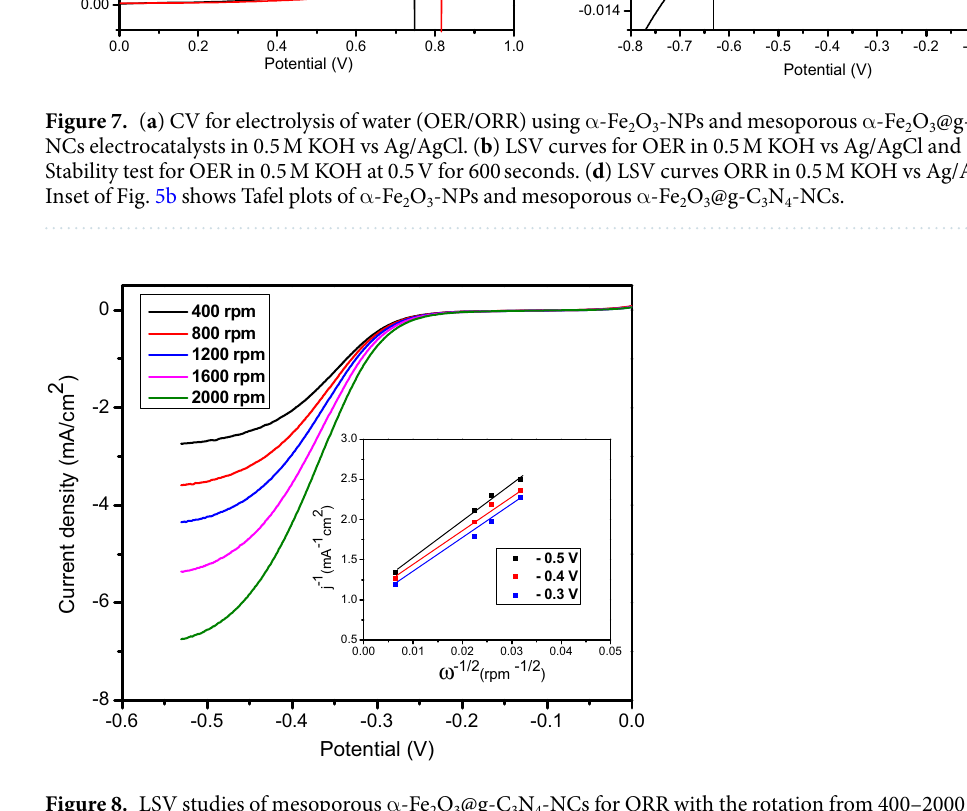
(A.cm − 2 ); F: Faraday’s constant (C.mol − 1 ); D o : Diffusion coefficient of O 2 in 0.5 M KOH; ν : Kinematic viscosity of the electrolyte (cm 2 s − 1 ), C o : Saturation concentration of O 2 in 0.5 M KOH at 1 atm O 2 pressure (mol.cm − 3 ); ω : rotation rate (rad.s − 1 ).